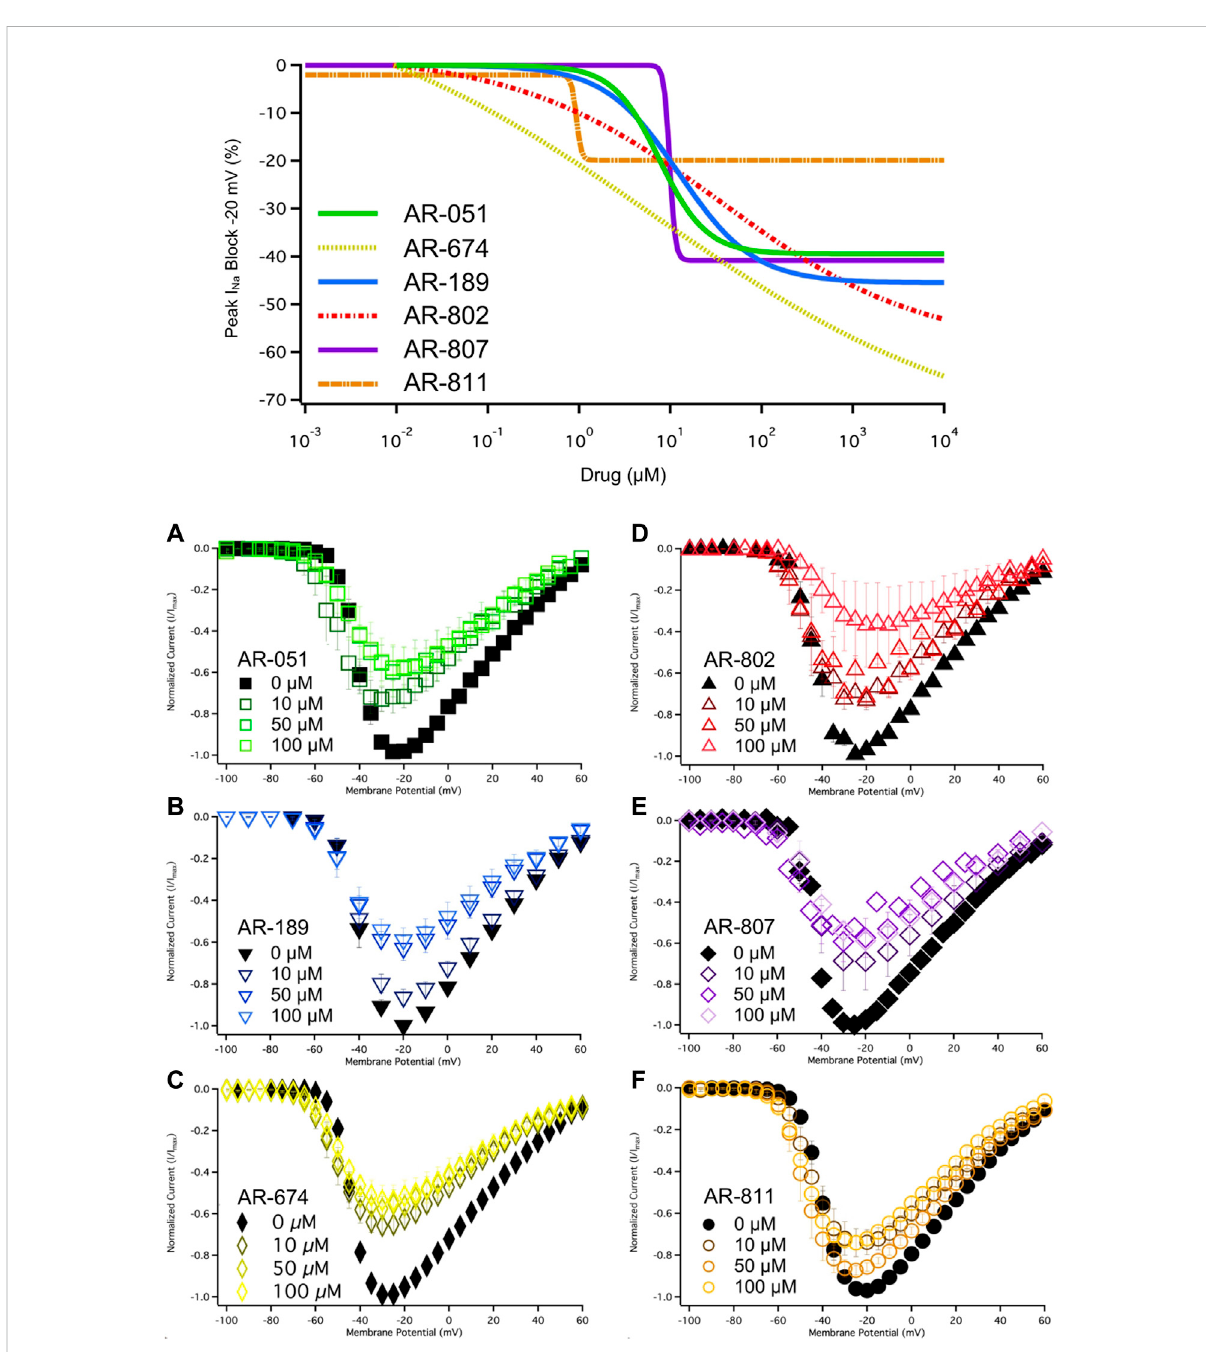
FIGURE 3 Dose-Response and current-voltage relationships. A dose-response curve was fi tted to the compound concentrations for peak INa block at – 20mV,generatinghillcurvesshownatthetopofthe fi gure.ParametersfromtheHillfunctioncurvearereportedinTable4. (A-F) showthecurrent- voltage relationship for vehicle (black) and compound treatment between 0 – 100 μ Ms (varied colors). Statistical signi fi cance is reported in Table